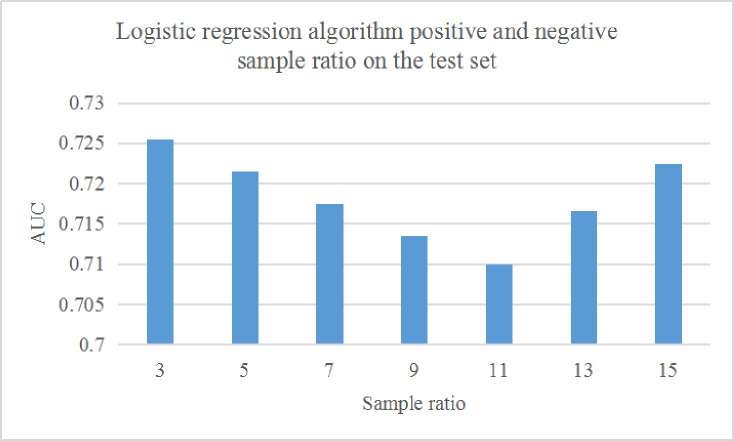
Logistic regression algorithm positive and negative sample ratio on the test set AUC results graph.